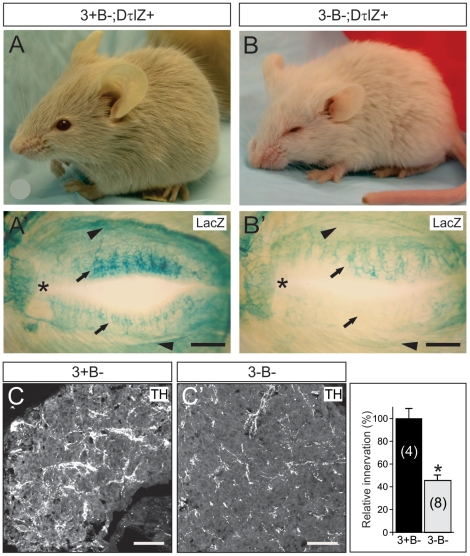
Disruption of sympathetic target tissue innervation originating from the SCG in the absence of neuron death in Egr3-deficient mice.(A) Compared to 8 week old Bax-deficient control mice (3+B−) (B) physiologic ptosis and (B') innervation abnormalities to the eye were present in the absence of Egr3 and Bax (3-B−). Results show lacZ staining in mice also expressing the DτlZ sympathetic reporter transgene which highlighted (B') superior tarsus muscle innervation (arrowheads) and meibomian gland (arrows) innervation abnormalities to the eyes in 3-B− mice compared to (A') 3+B− control mice. (* = nasal canthus; scale bar = 100 µm). (C, C') Sympathetic innervation to the pineal gland, a major target of SCG neurons, was reduced by >50% in 3-B− mice compared to 3+B− control mice (4–8 weeks old). (scale bar = 200 µm)